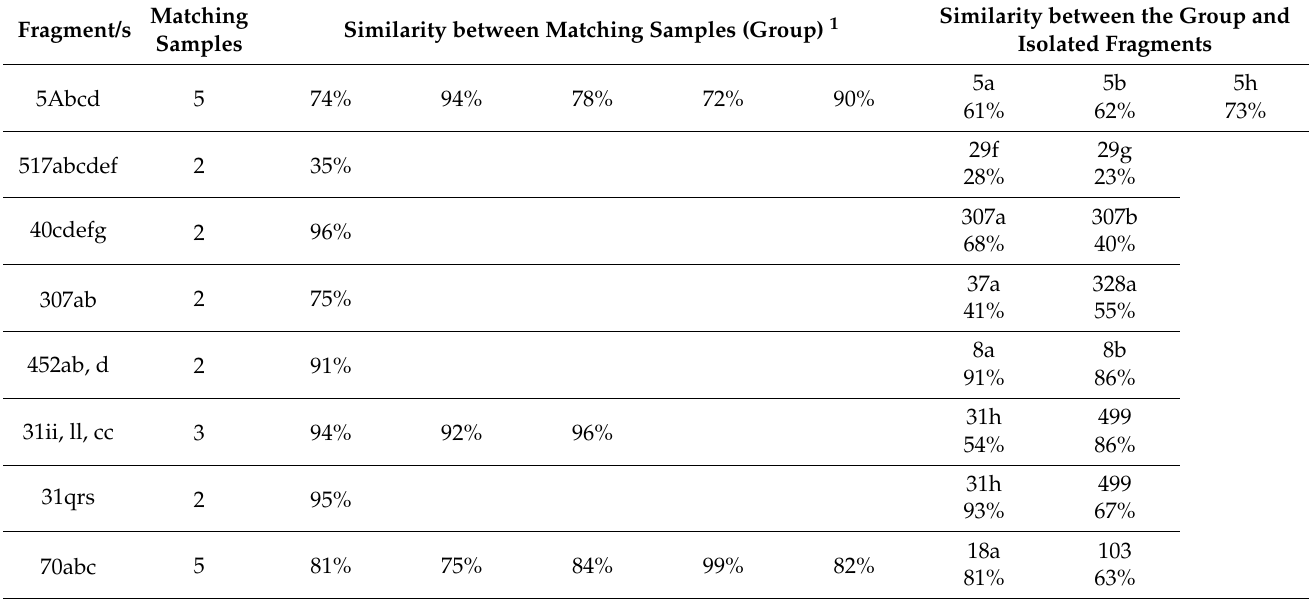
Table 4. Similarity between the averaged CL color of every sample and the centroid computed with samples of the same fragment (or other matching fragments). On the right, the similarity between the centroid and isolated (not matching) fragments is